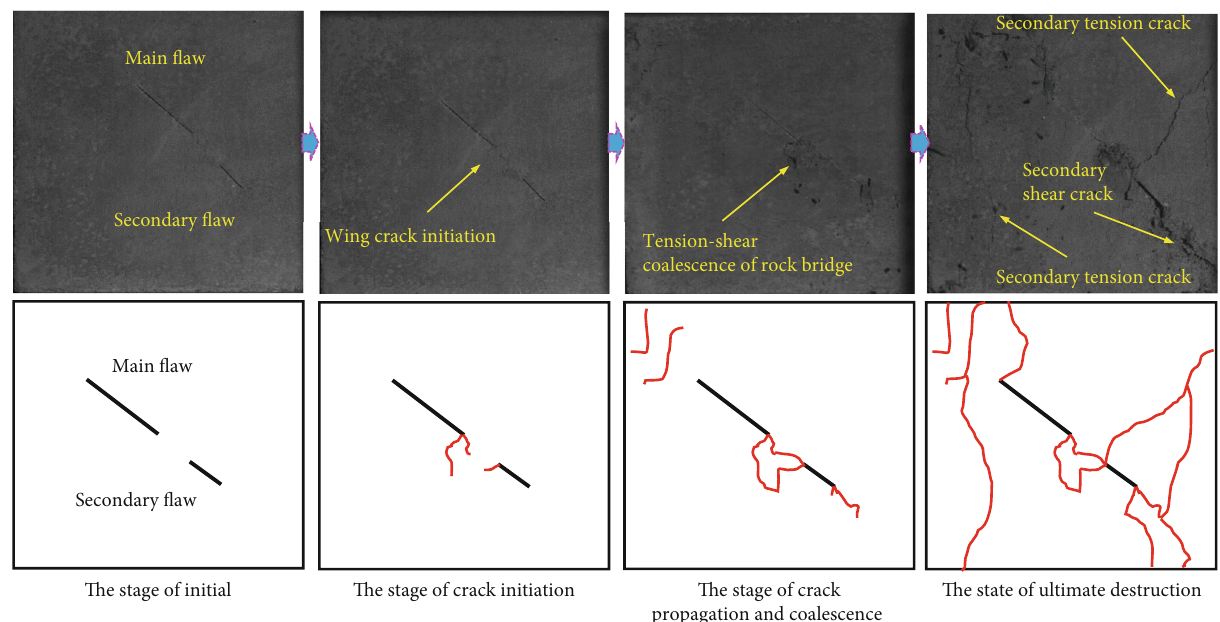
Figure 12: Crack propagation process of test specimen 2: α = 45 ° , 2 l